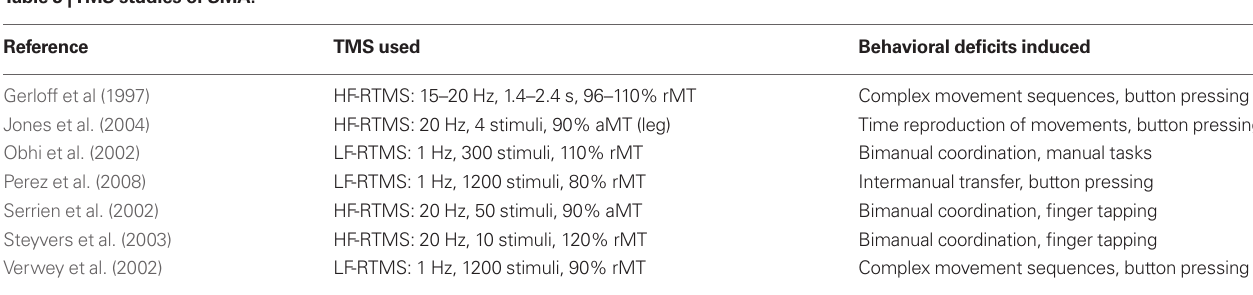
Table 3 | TMS studies of